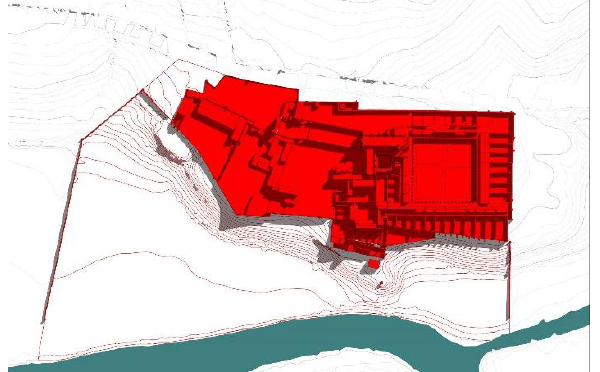
Figure 5: Delimitation plan view. HBIM Charterhouse of Jerez, phase 15, Sisters of Bethlehem (2000-…)